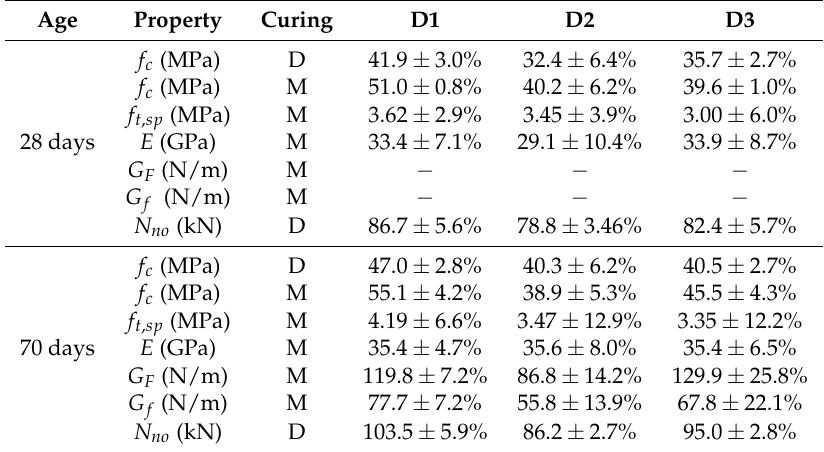
Table 2. Compressive strength, tensile strength, elastic modulus, fracture energy and pull-out tests results for the different